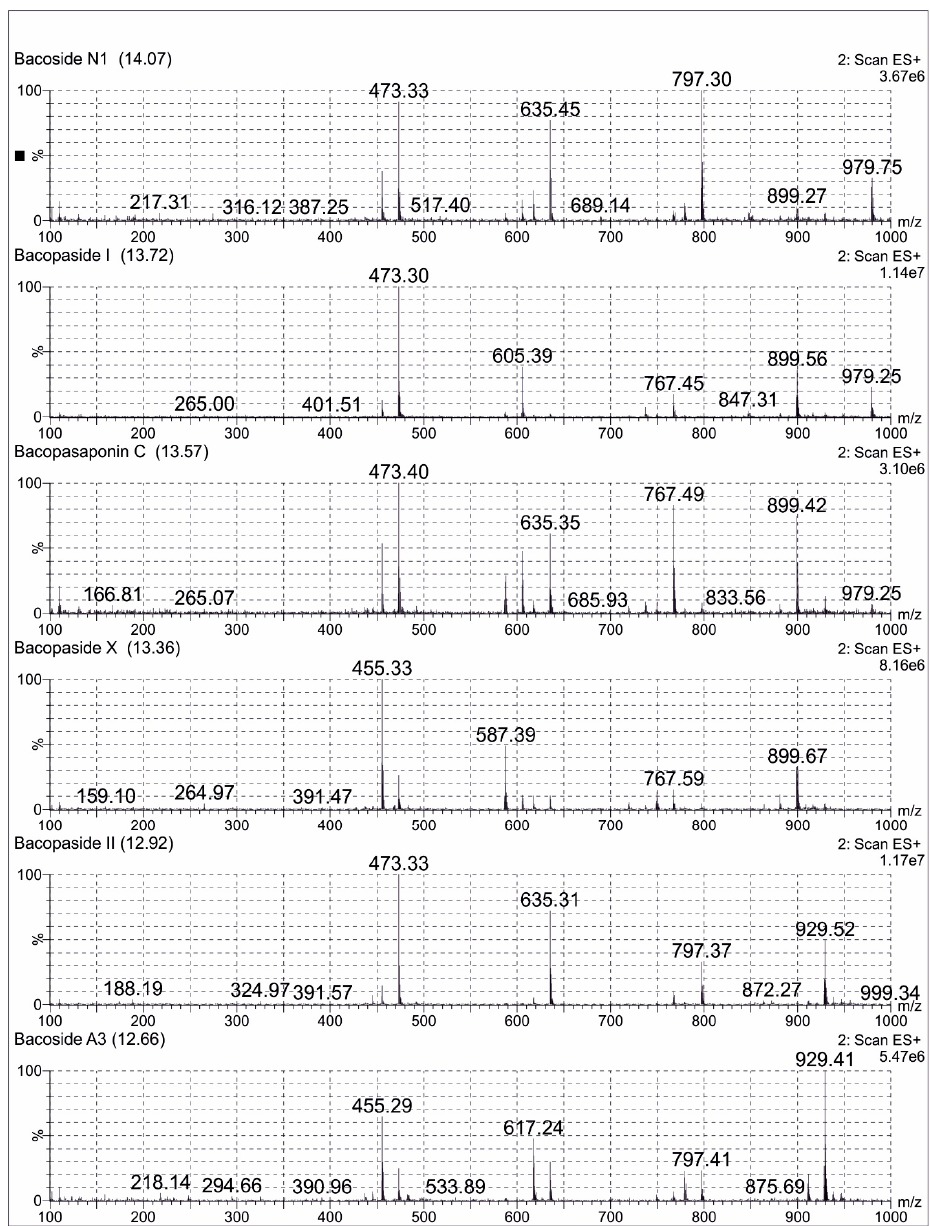
Figure 2. Positive ion electrospray ionisation liquid chromatography -mass spectrometry mass Scheme 1. Bacopaside 1, Bacopasaponin C, Bacopaside X, Bacopaside II and Bacoside A3 separated in Brahmi extract.